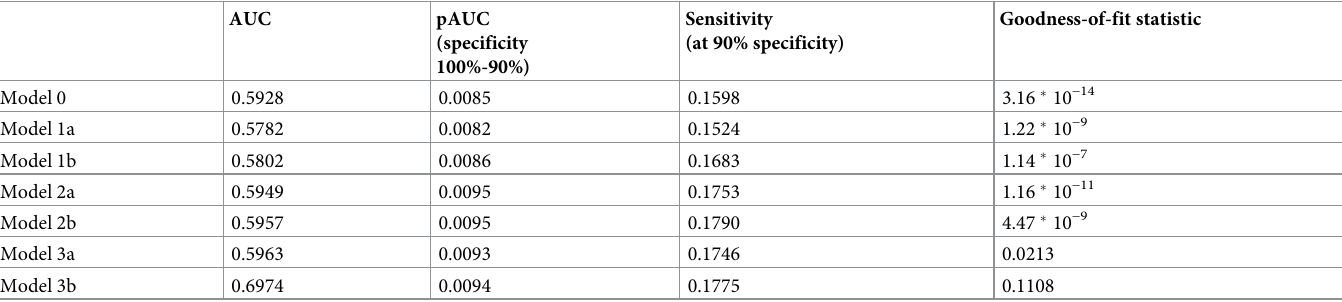
Goodness-of-fit